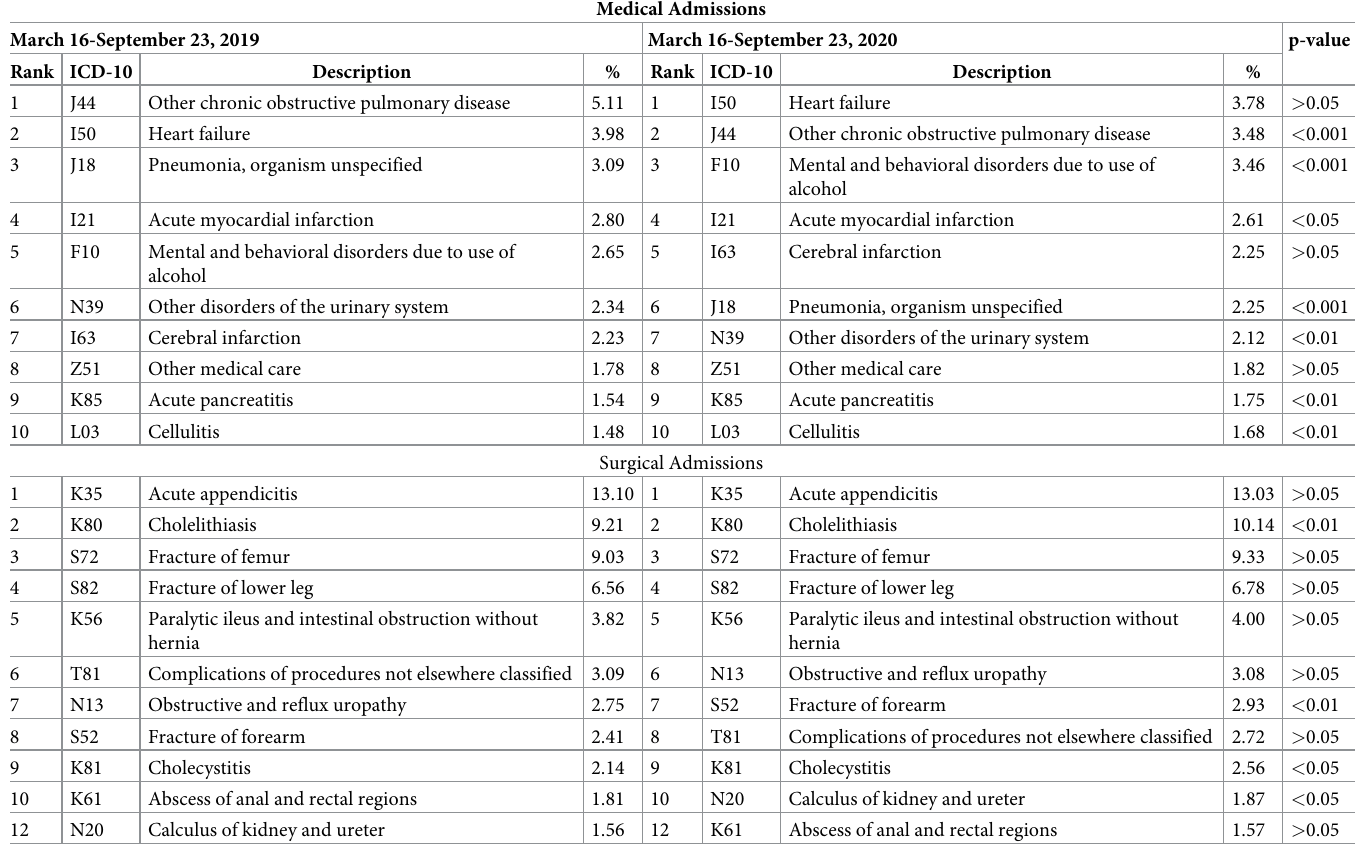
Table 4. Top diagnoses March 16-September 23, 2020 (post COVID-19 public health measures) compared to top diagnoses March 16-September 23, 2019. Medical